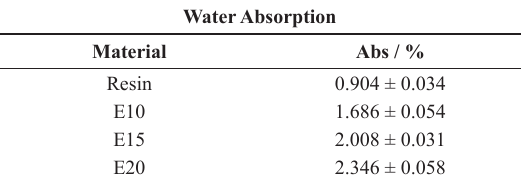
Table 4. Water absorbtion.